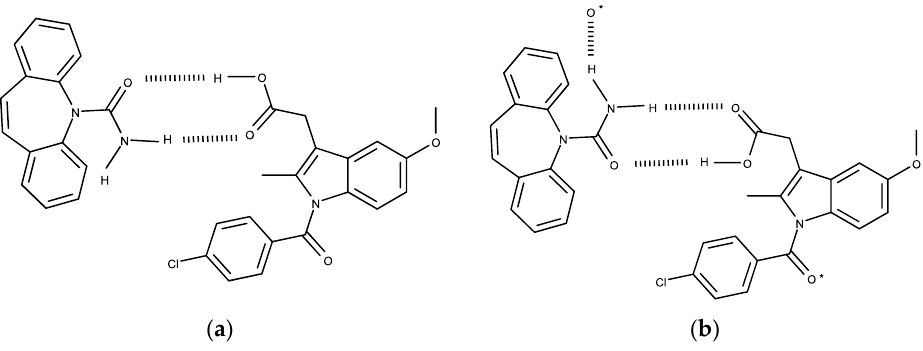
Figure 3. Hydrogen bonding motifs in the CBZ:IND form II structure solutions ( a ) as found in the initial DASH solution and ( b ) after 180 ° rotations of both the amide and carboxylic acid groups. The * indicates the oxygen atom involved in the third hydrogen bond.